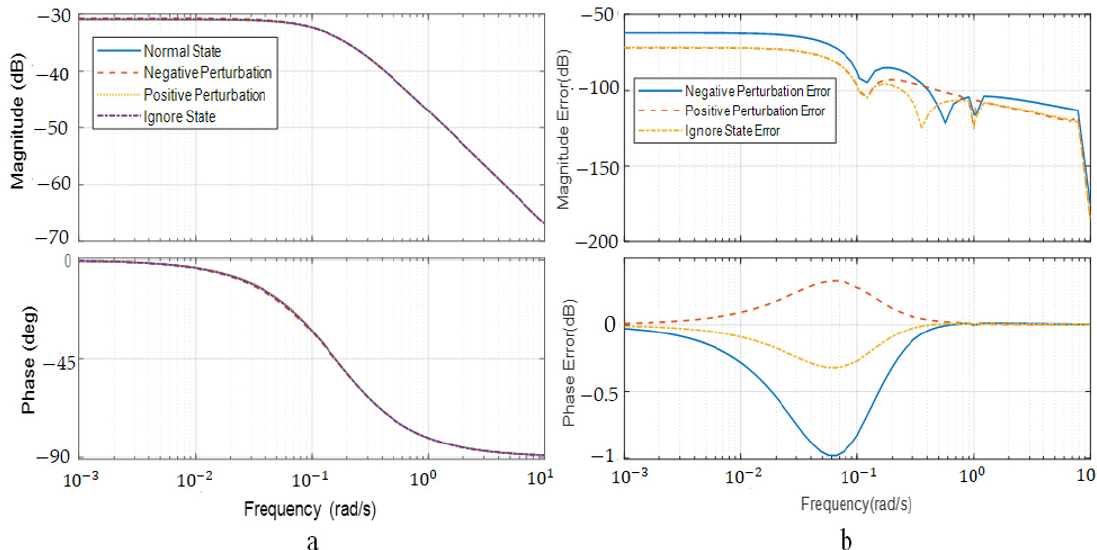
Figure 7. Bode Plot and Deviation Curve of Yaw Channel in Perturbation State of Moment of Yaw Aerodynamic Stabilization: (a) Bode plot of the yaw channel in the perturbation state of the yaw aerodynamic stability moment, (b) amplitude frequency and phase frequency deviation curves of the yaw channel in the perturbation state of the yaw aerodynamic stability moment.